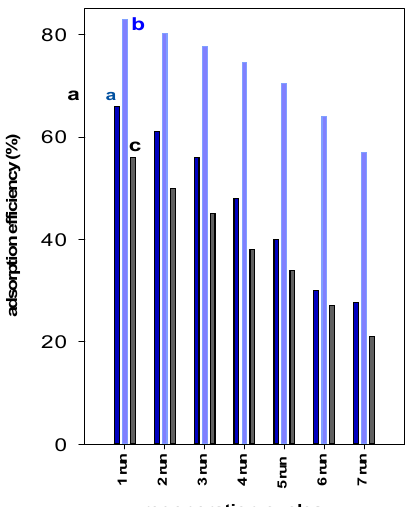
BB-41 initial solution of 200